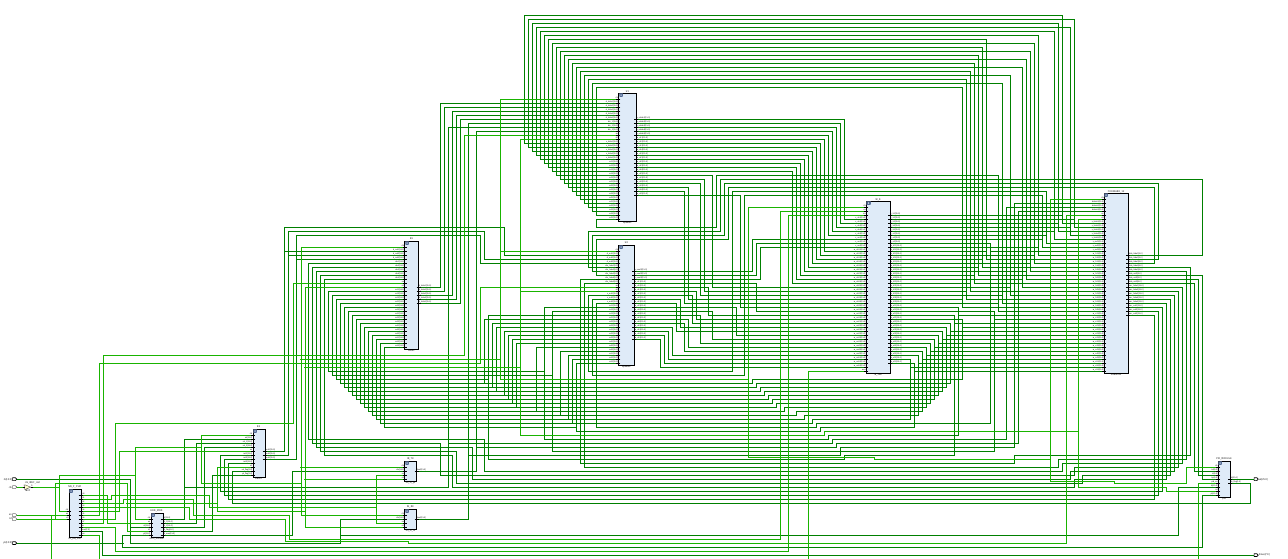
Figure 5. BP neural network PID controller: top-layer RTL schematic.